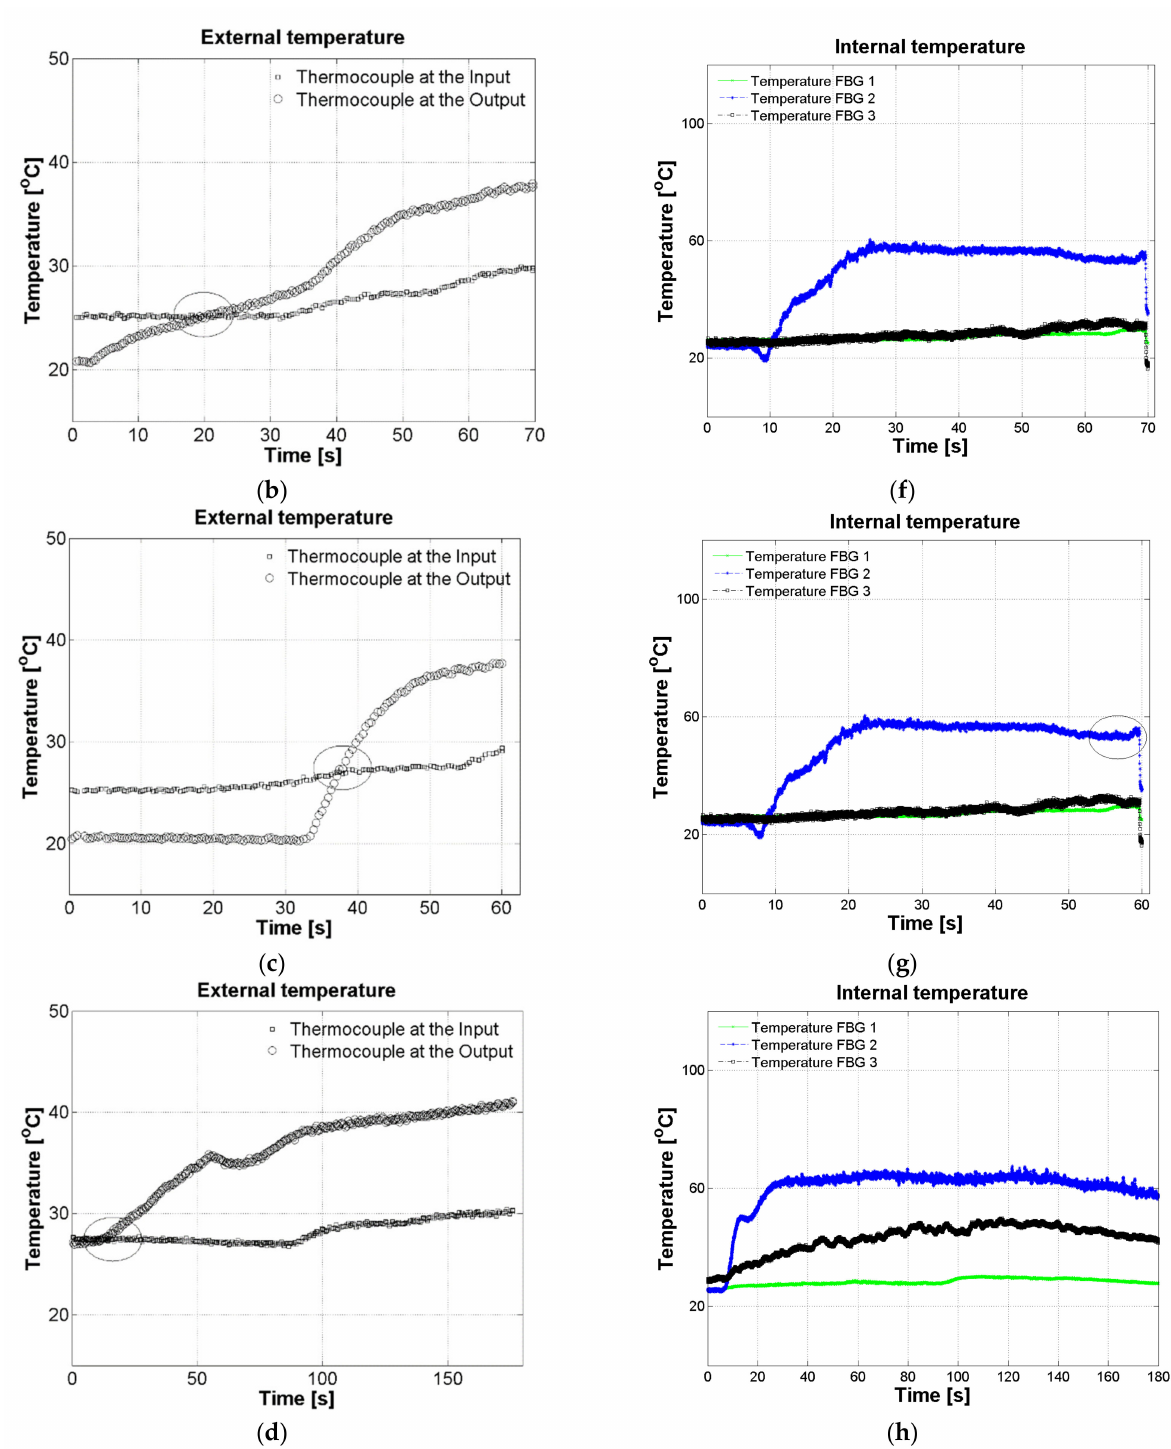
Figure 10. Temperature as function of time using water with dissolved sugars. Outer temperatures measured by thermo- couples in ( a ): 60 s ( b ): 70 s ( c ): 60 s and ( d ): 180 s. Inner temperatures measured by FBG temperature sensors in ( e ): 60 s ( f ): 70 s ( g ): 60 s and ( h ): 180 s. Blue and black lines indicate FBG 2 and 3 in contact with the water. Green line indicates FBG 1, the temperature inside the microwave